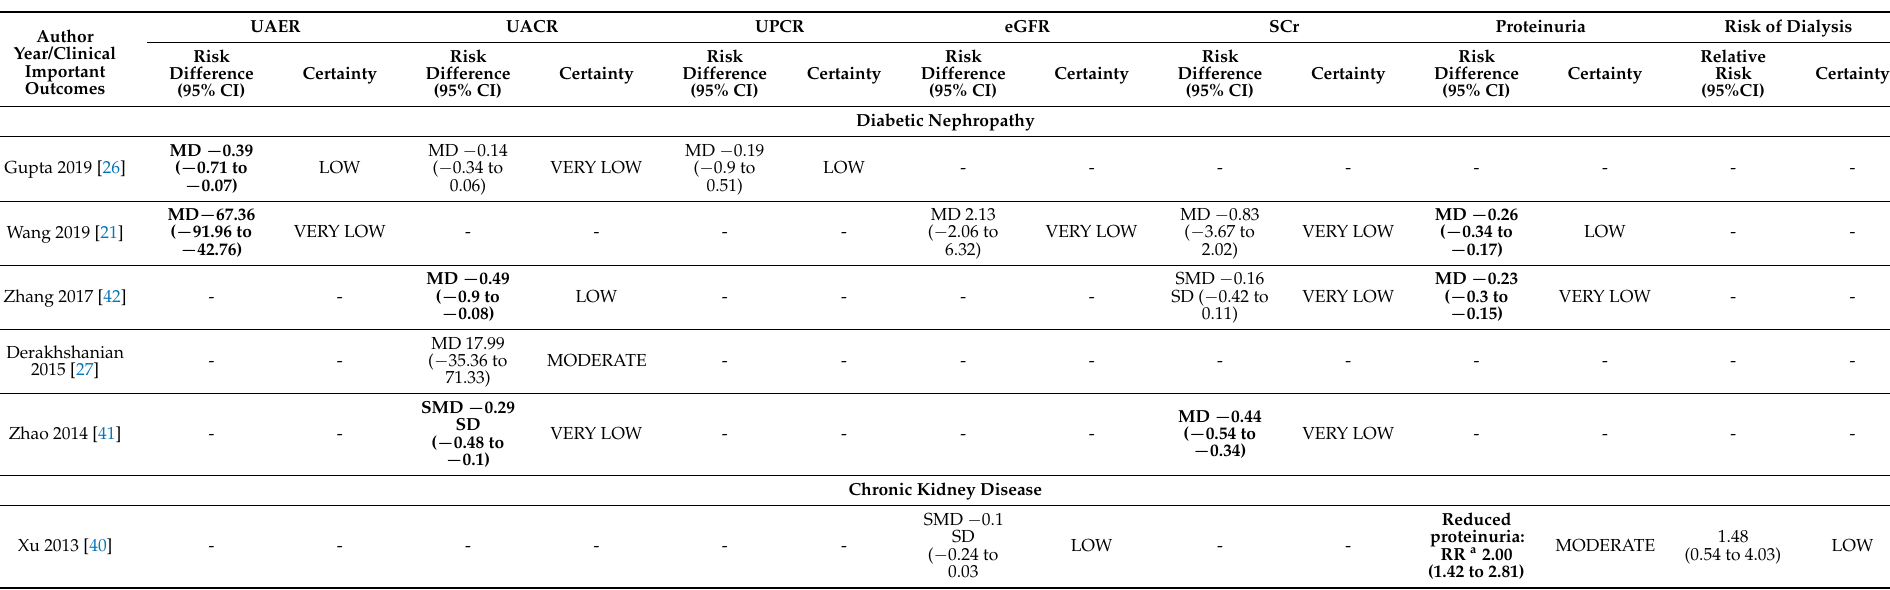
Table 4. Summary of clinical important outcomes and certainties on the renal protection effect of vitamin D and analogues compared to